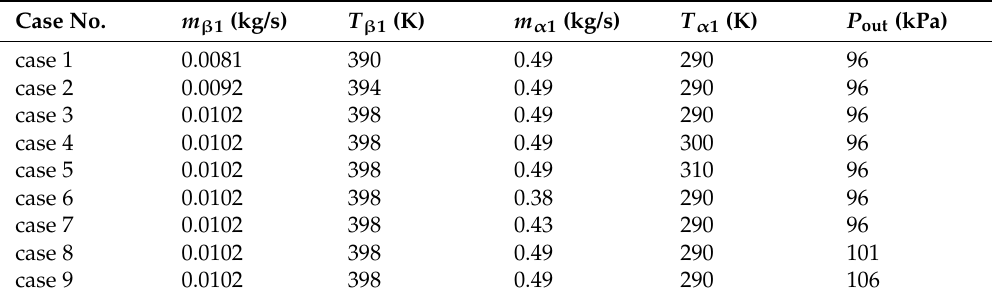
Table 3. Operating conditions in numerical